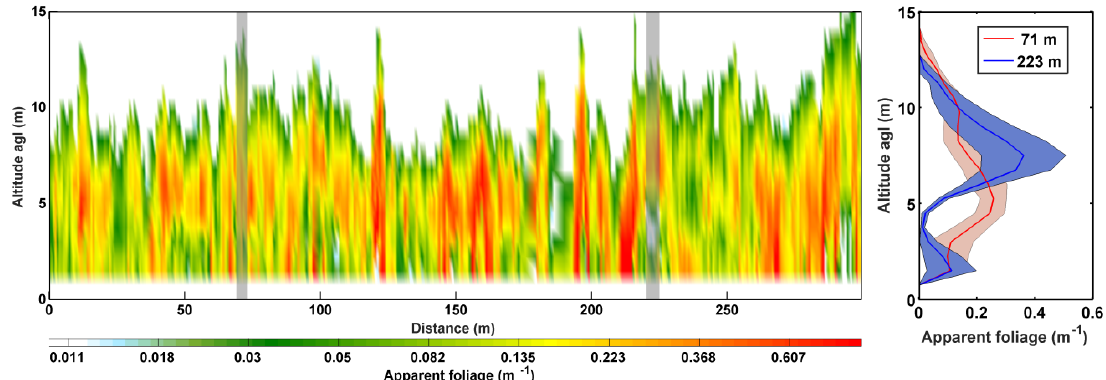
Figure 8. Evolution of the forest vertical profile of the LiDAR-derived apparent foliage ( F app ) along a transect of the Bélouve site (BF, left panel). Two specific vertical profiles are shown in the right panel, and their locations are highlighted in transparent gray in the left panel.